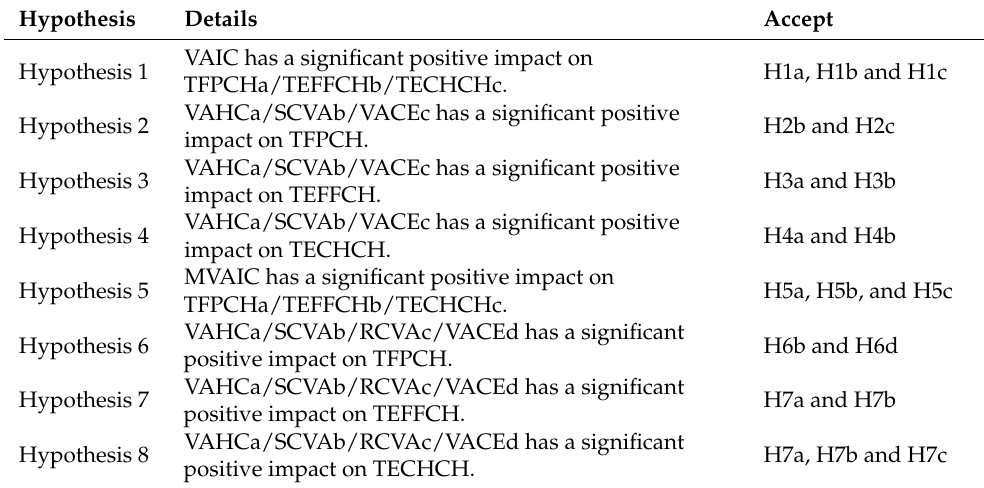
Table 6. Hypotheses testing